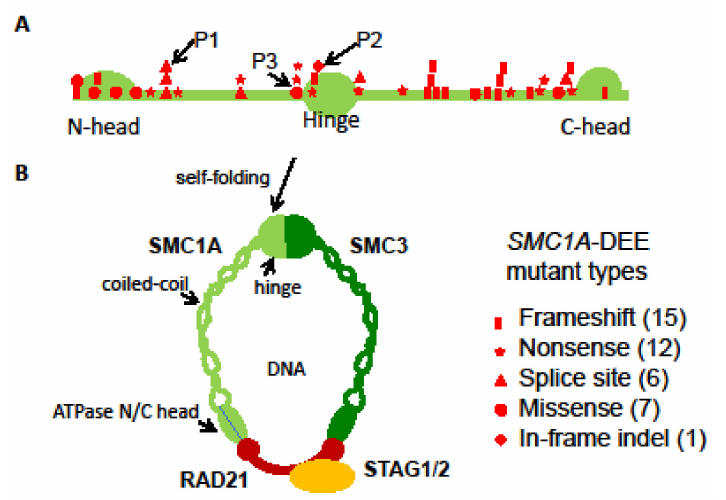
Figure 2. SMC1A -DEE variants. ( A ) Location and types of 41 SMC1A -DEE variants, including 39 reported and 2 new ones shown on the SMC1A protomer (see Table 1). Variants of our patients 1–3 are marked. ( B ) After self-folding of the coiled-coil, SMC1A and SMC3 form a hinge domain at one end and bind to RAD21 at the other end (N/C head). Finally, RAD21 interacts with STAG1/2 and forms a ring-shaped cohesin complex to fold chromatin. The number of assembled cohesin would be reduced by these